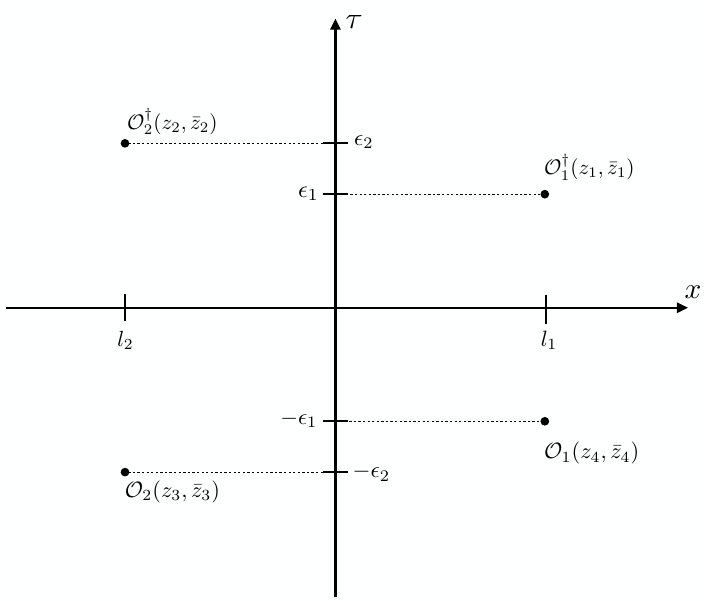
Figure 45 . Path integral representation of the density matrix of our